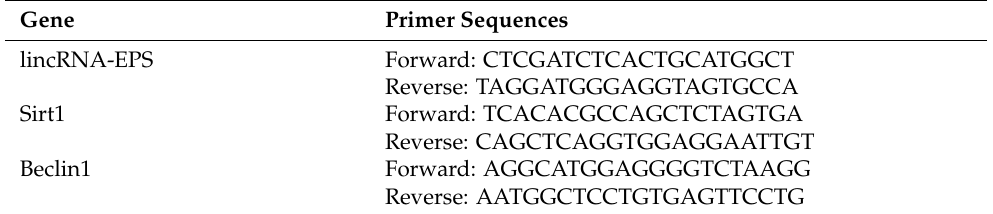
Table 1. Summary of primer sequences used for